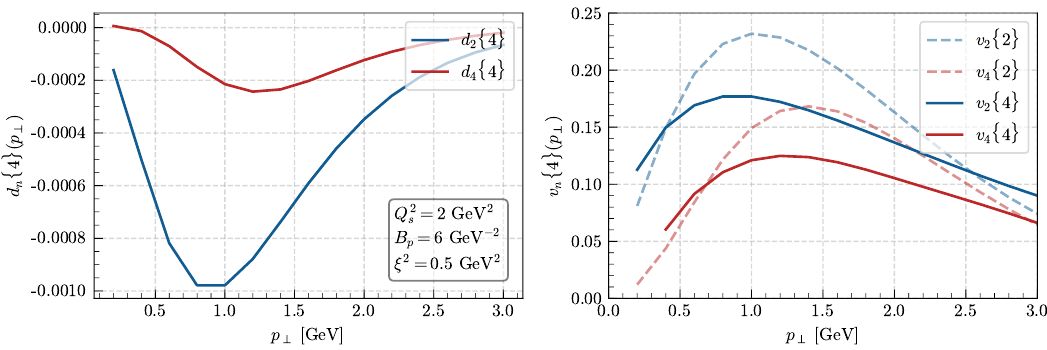
Figure 2: Dependence of the differential 4-particle cumulant (left) and azimuthal harmonic (right) of second and fourth order with p ⊥ . For the latter we also show the results obtained from 2-particle